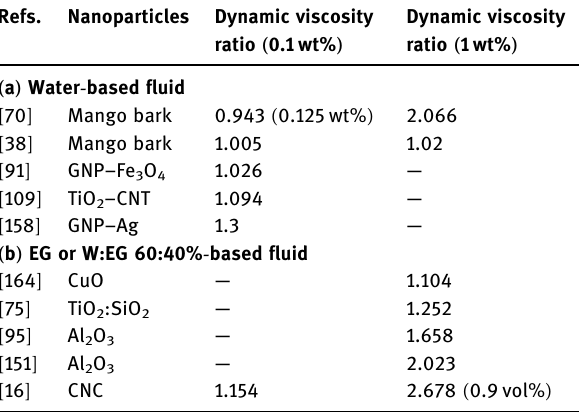
Table 3: Dynamic viscosity ratio for nano fl uids